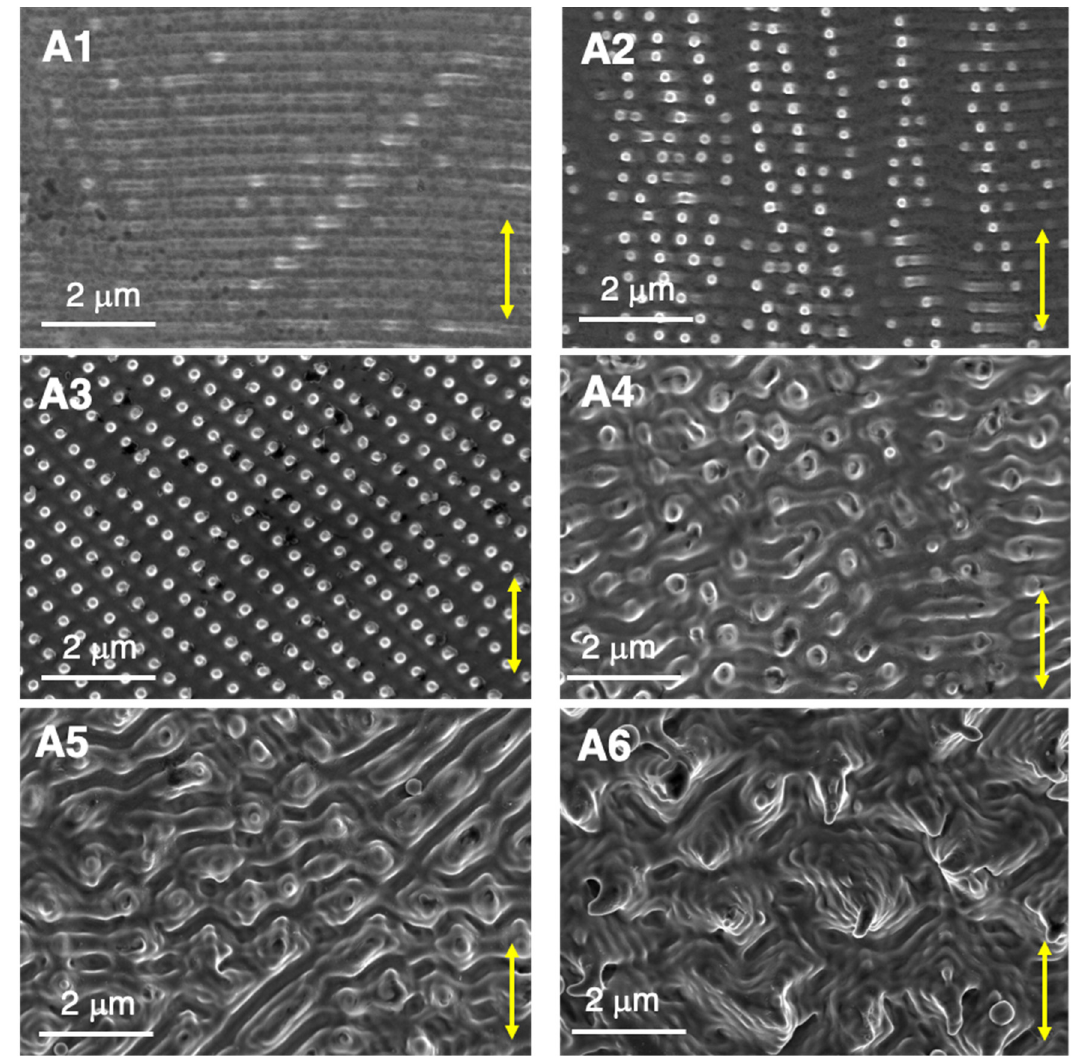
Figure 6. Top-view SEM (in-lens) micrographs of nanostructures and microstructures generated on Ni5W tape using low F av and < F 1D > fluence values, as explained in the text and in Table 2. The yellow double-arrows indicate the linear laser beam polarization direction. Table 2. 2D (area) laser processing parameters of samples A1 to A10. The laser was operated at f rep = 800 kHz for A1–A6 and at 300 kHz for A7–A10,